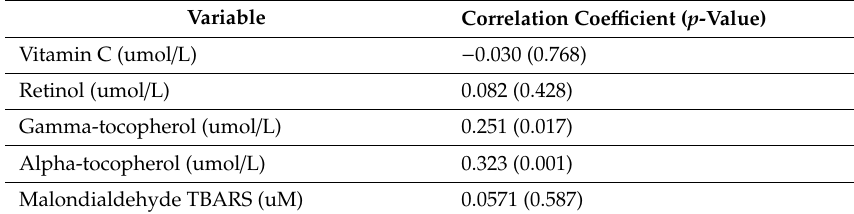
Table 2. Correlation between CIMT and antioxidants.